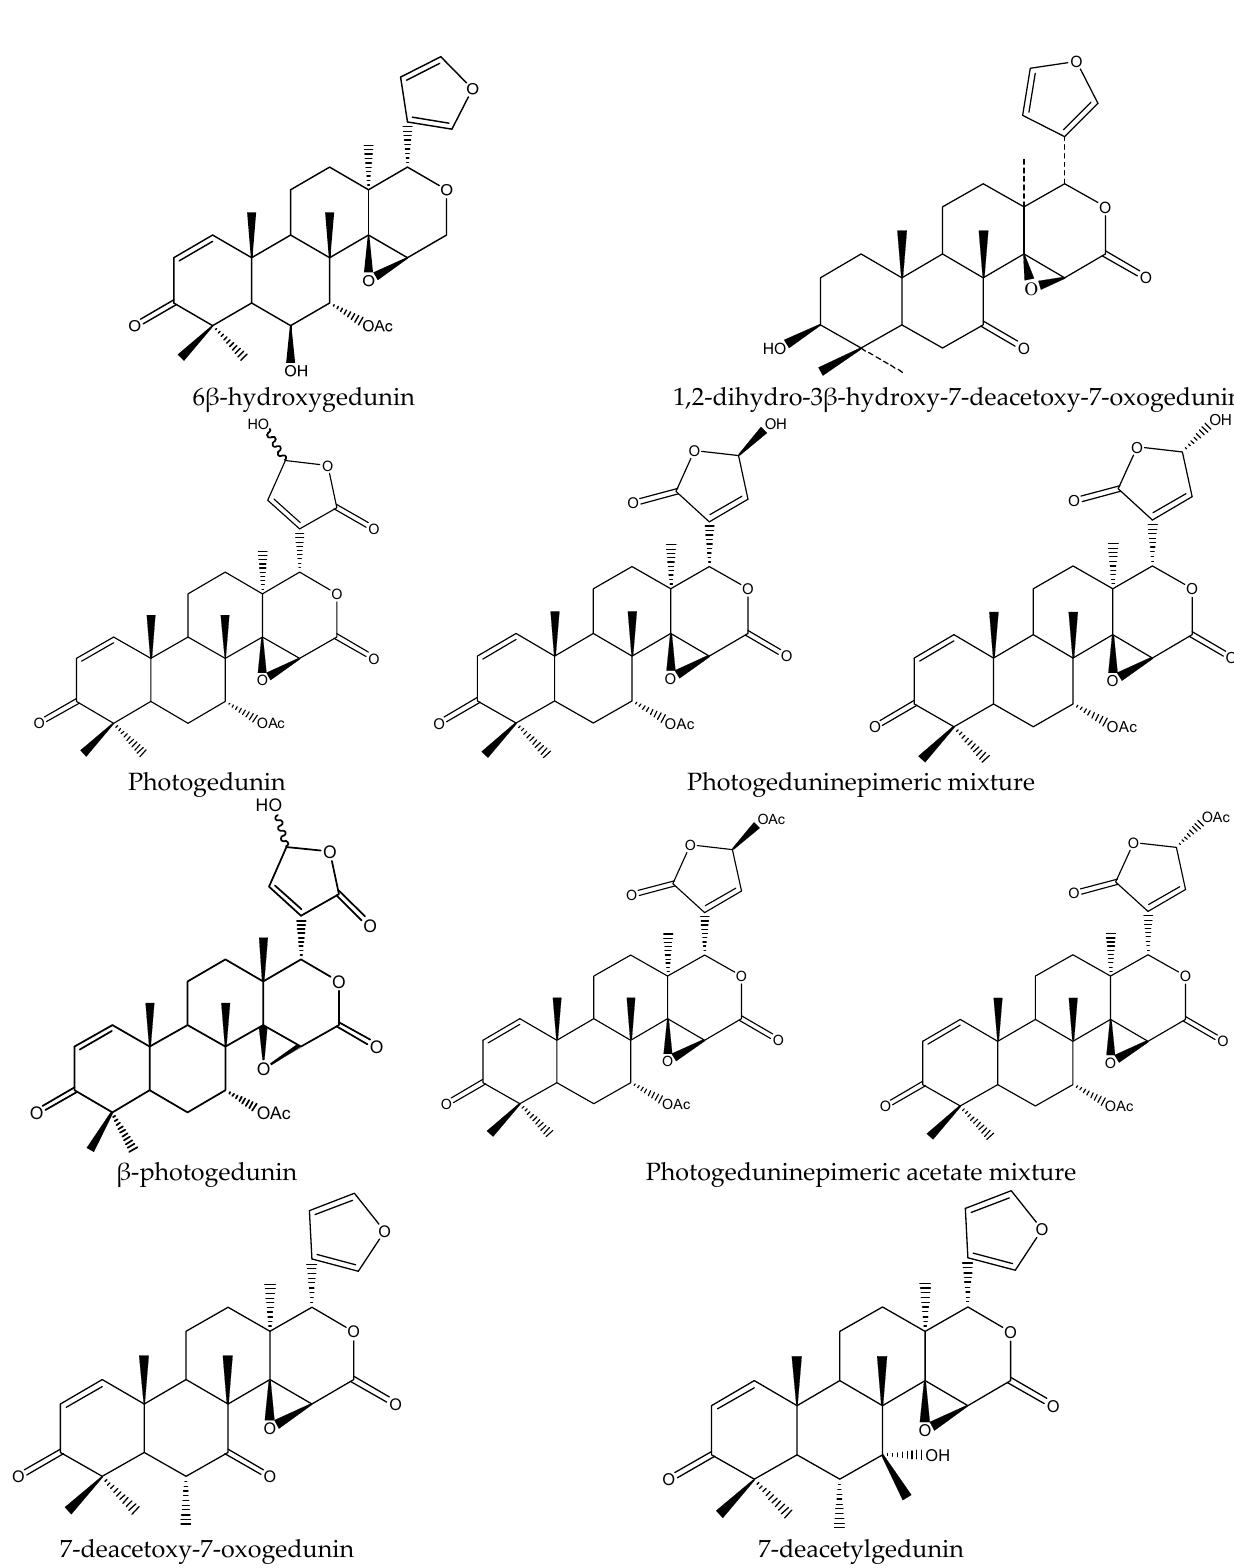
Figure 9. The structures of ring D-seco chemicals.